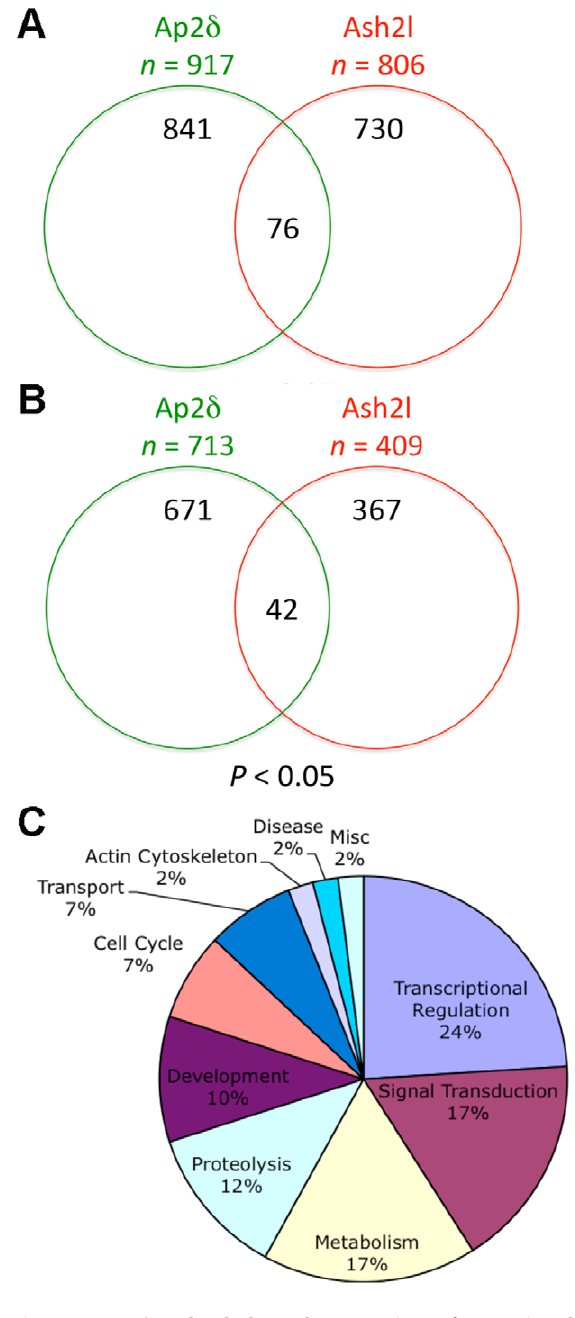
Figure 2. Ap2 d and Ash2l regulate a variety of genes involved in development. ( A ) Downregulation of Tcfap2d and Ash2l in cells leads to the differential expression of 917 and 806 genes, respectively. Comparison of these groups yields 76 genes whose expressions are changed when both Tcfap2d and Ash2l levels are reduced. ( B ) Among the 713 and 409 genes that are downregulated when Tcfap2d or Ash2l are decreased, respectively, 42 genes are decreased when both genes are reduced. ( C ) Functional annotation based on gene ontology (GO) reveal that the majority of the 42 genes encode for a variety of developmental proteins involved in transcriptional regulation and signal transduction. Microarray analysis was performed with cDNAs obtained from Neuro2a cells treated with either Tcfap2d - or Ash2l - specific RNAi or a scrambled control. Signal values were calculated using the MAS5 and PLIER statistical algorithms. Genes with a significance level of p , 0.05 as compared to the scrambled control were selected for